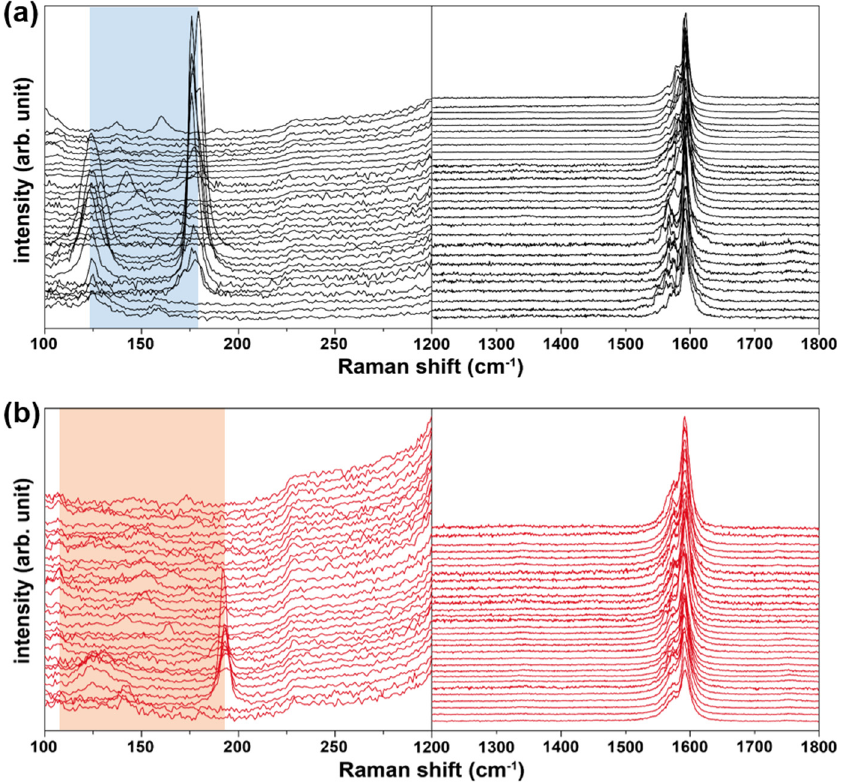
Figure 6. Raman spectra recorded for the ( a ) central region and ( b ) maximum-synthesis-yield regions. The sample was grown at 900 °C with H 2 :CH 4 = 25:225 sccm. Regions where RBM peaks were detected are denoted by blocks of color.